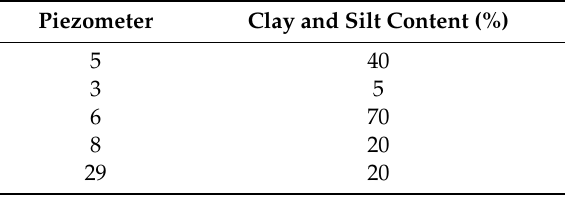
Table 2. Content of clay and silt in the considered piezometers. Piezometer Clay and Silt Content